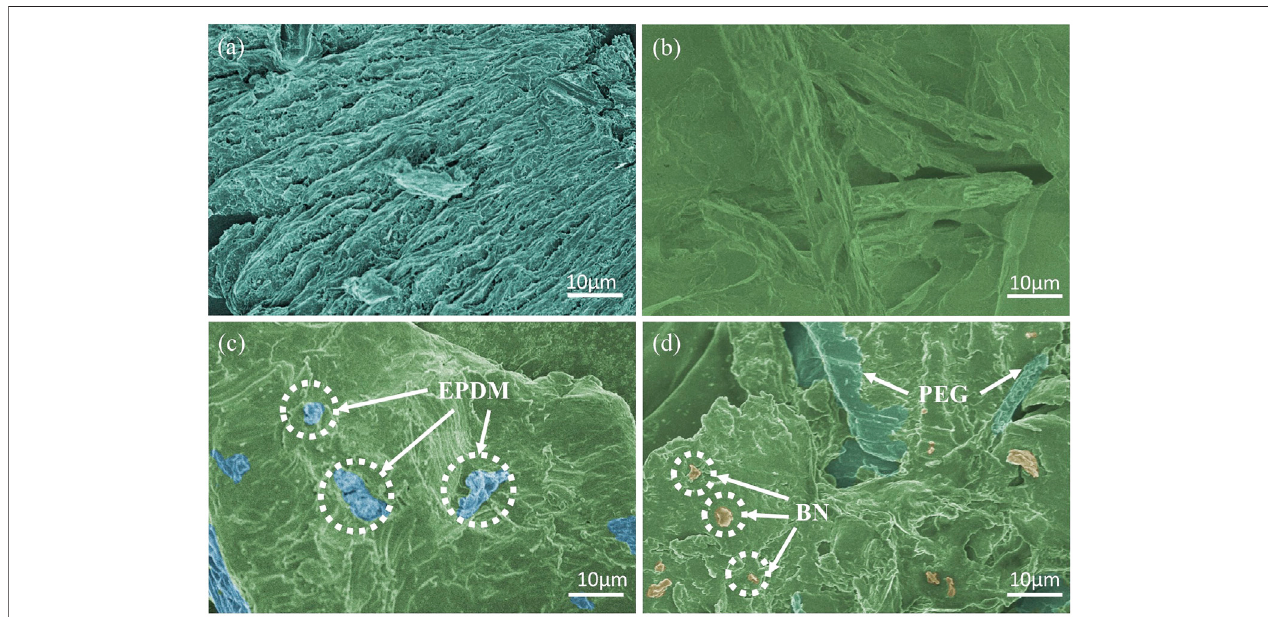
FIGURE 4 | SEM images of (A) polyethylene glycol (PEG), (B) styrene – butadiene – styrene (SBS), (C) SPE4, and (D) SPEB7.